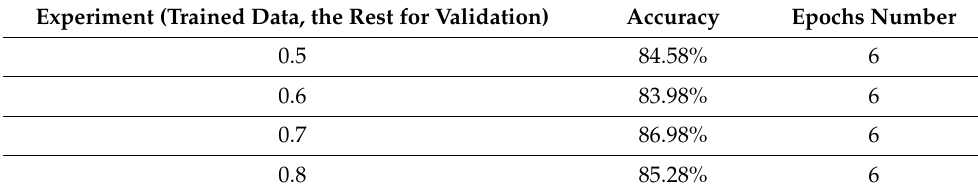
Table 5. Cross-validation and simulation results for Alex-Net classifier. Experiment (Trained Data, the Rest for